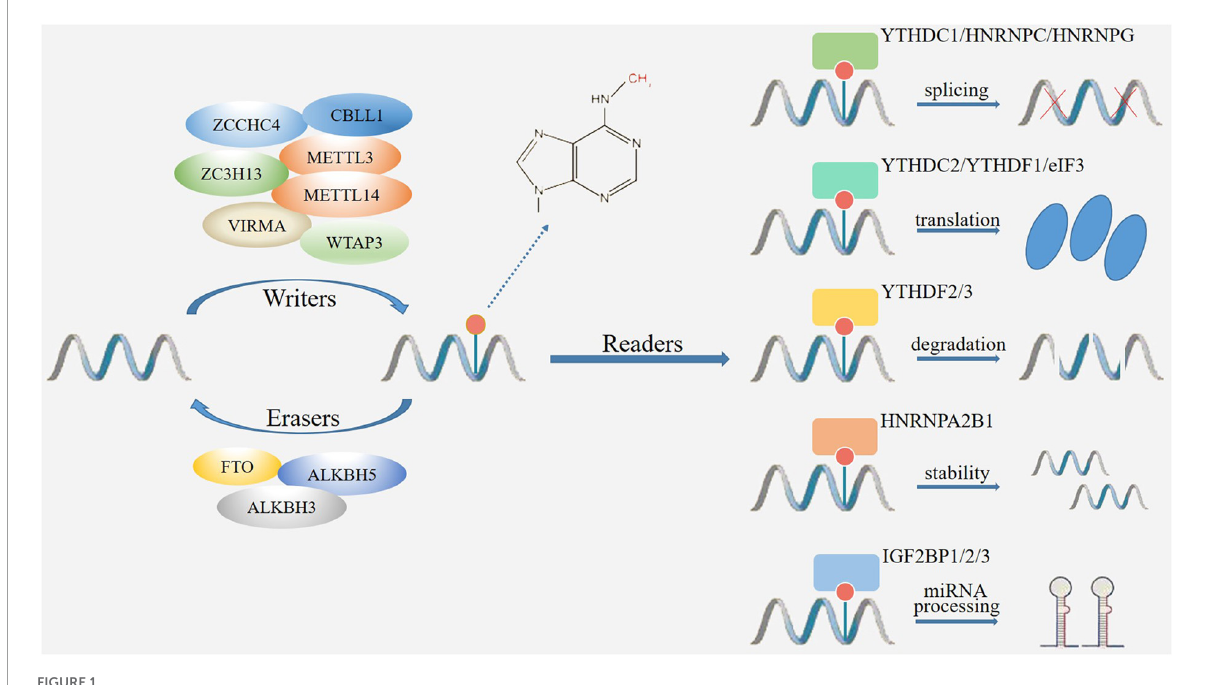
FIGURE1 The mechanism of m6A modification. M6A modification is catalyzed by methyltransferase and demethylase acting as writers (METTL3, METTL14, WTAP3, VIRMA, ZC3H13, ZCCHC4, CBLL1) and erasers (FTO, ALKBH3, ALKBH5) to add and remove m6A. The m6A binding proteins (readers) include YTH and IGF2BP family proteins, which determine the fate of RNAs through changes in splicing, translation, degradation, stability, and miRNA